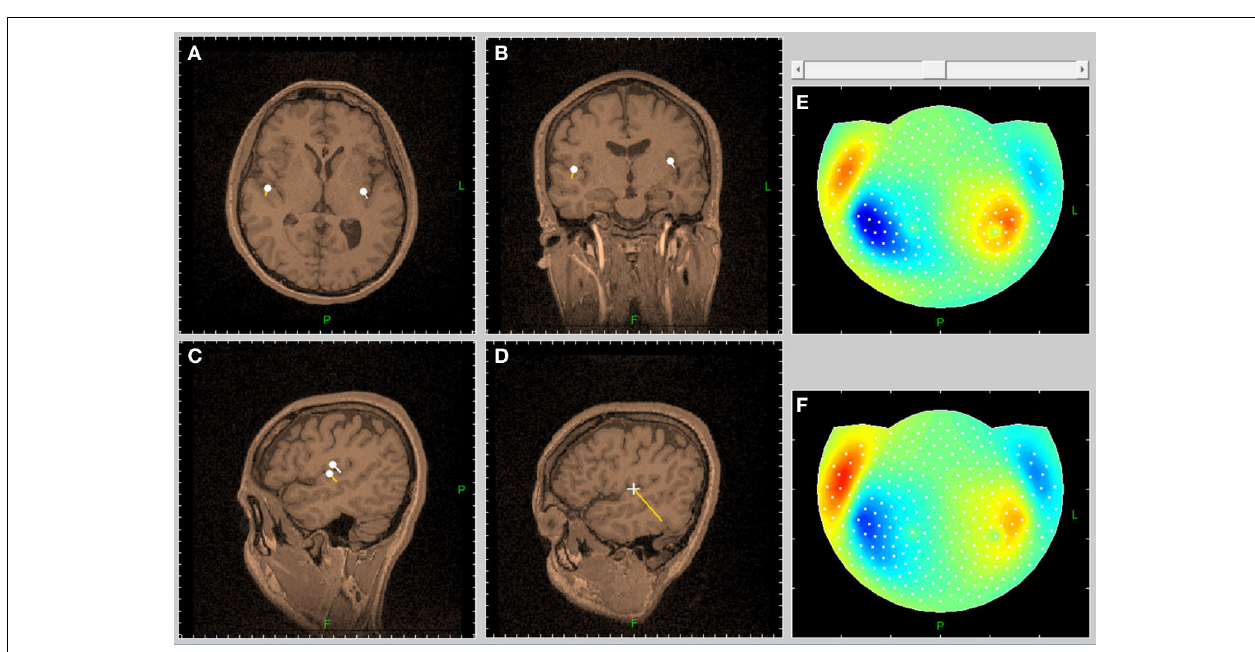
FIGURE 4 | The inverse problem solution reveals the spatial structure of the functional entity, producing the pattern of auditory response (Figure 3, middle pattern). This structure is well described by the two-dipole